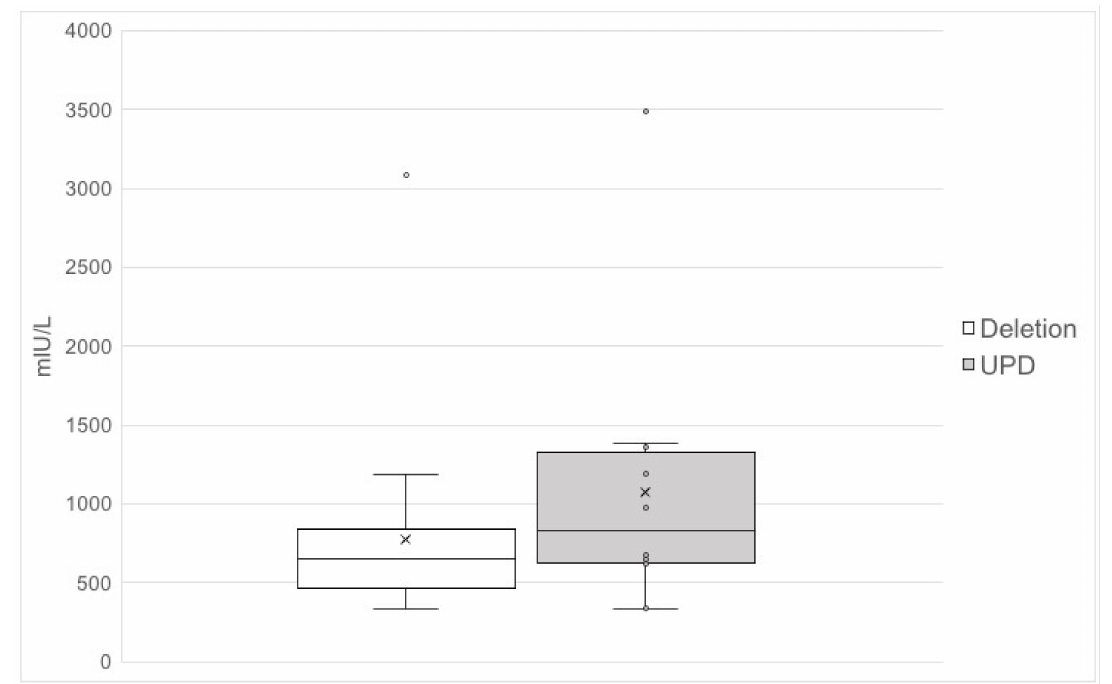
Figure 2. Prolactin levels in 24 adults with paternal chromosome 15q11–13 deletion and 14 adults with chromosome 15 maternal uniparental